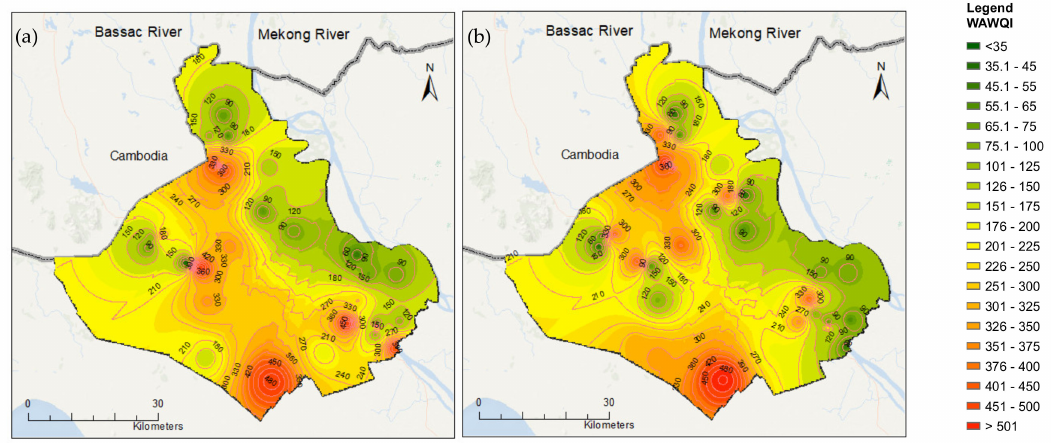
Figure 8. Spatial distribution of weighted arithmetic water quality index (WAWQI) in the ( a ) dry and ( b ) wet seasons using inverse distance weighting (IDW)